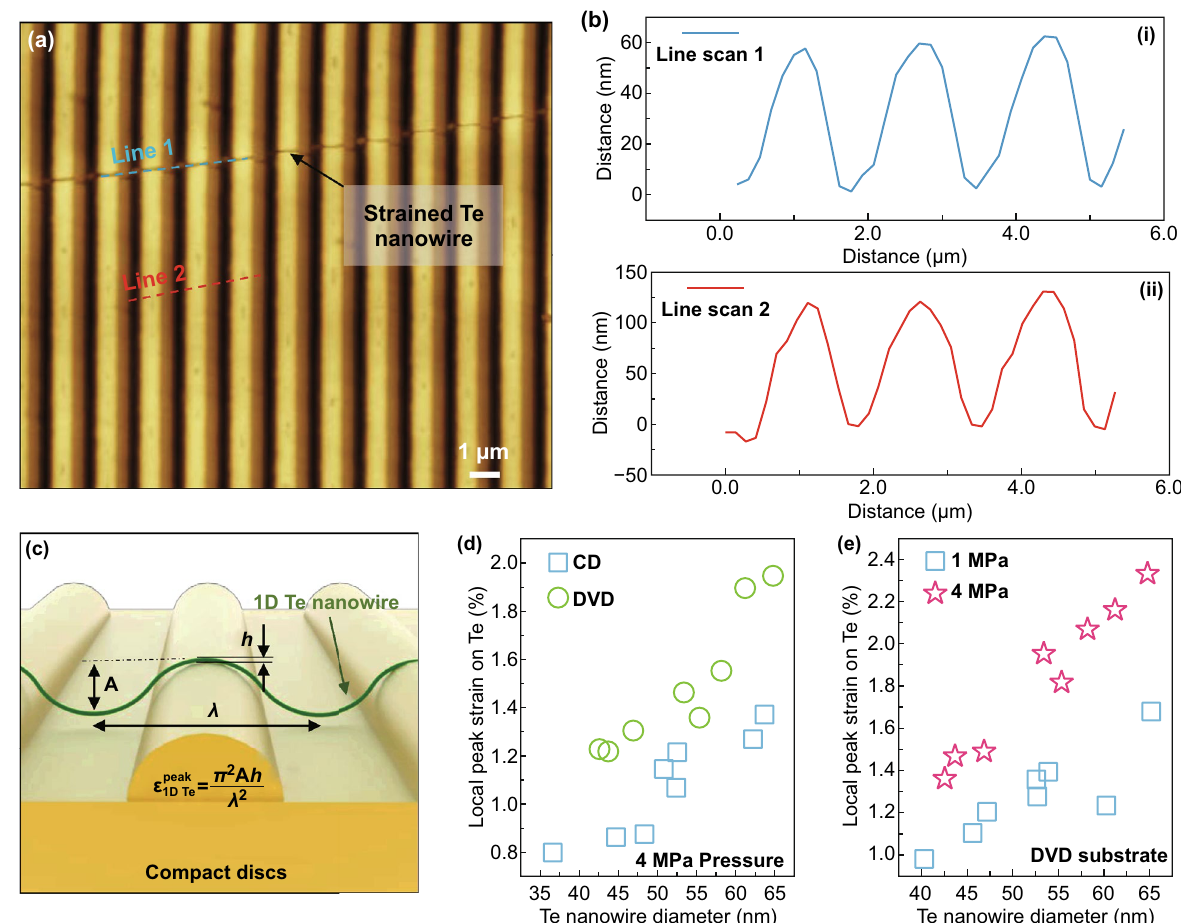
Fig. 3 Analysis of the deformed 1D Te on the optical disks. a Atomic force microscopes (AFM) image of the strained 1D Te nanowire on com- pact disks. b Two line-scan results from a . c The strain analysis of the deformed 1D Te nanowire on the compact disks. The relationship between the local peak strain and Te nanowire diameter d on different disks and e different nanoimprinting